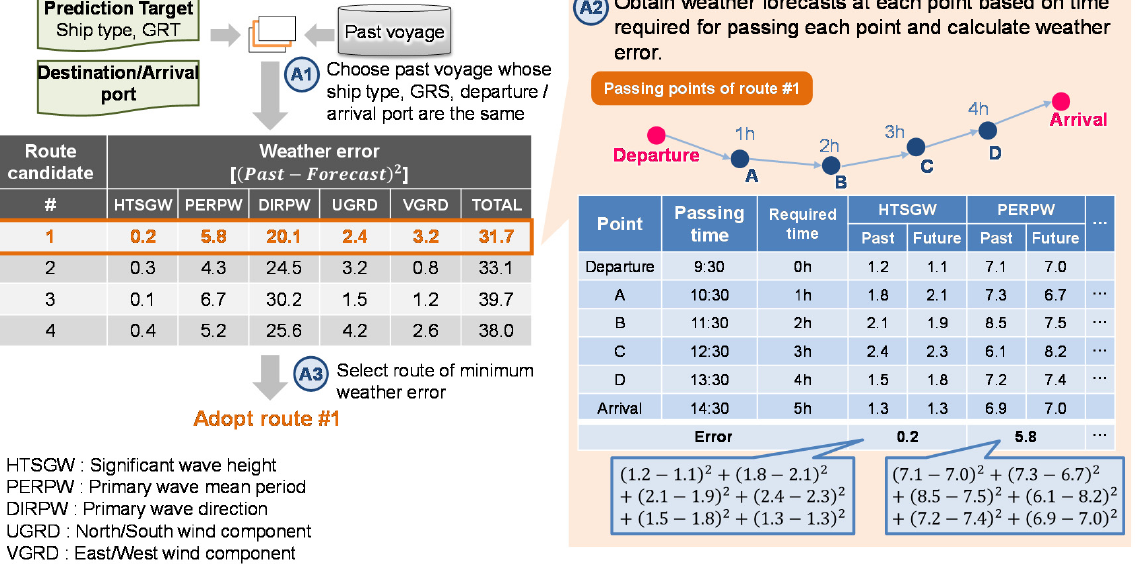
Figure 5. Example of similar vessels. Step A2 consists of acquiring past and future weather conditions for each past route found in A1 and quantifying the error involved. The sets, indexes, and constants used in the quantification process are detailed below. Moreover, Figure 6 shows a graphical image of the sets, indexes, and constants. In Figure 6, quantification is conducted for two routes. [Sets] 𝑅𝑂𝑈𝑇𝐸